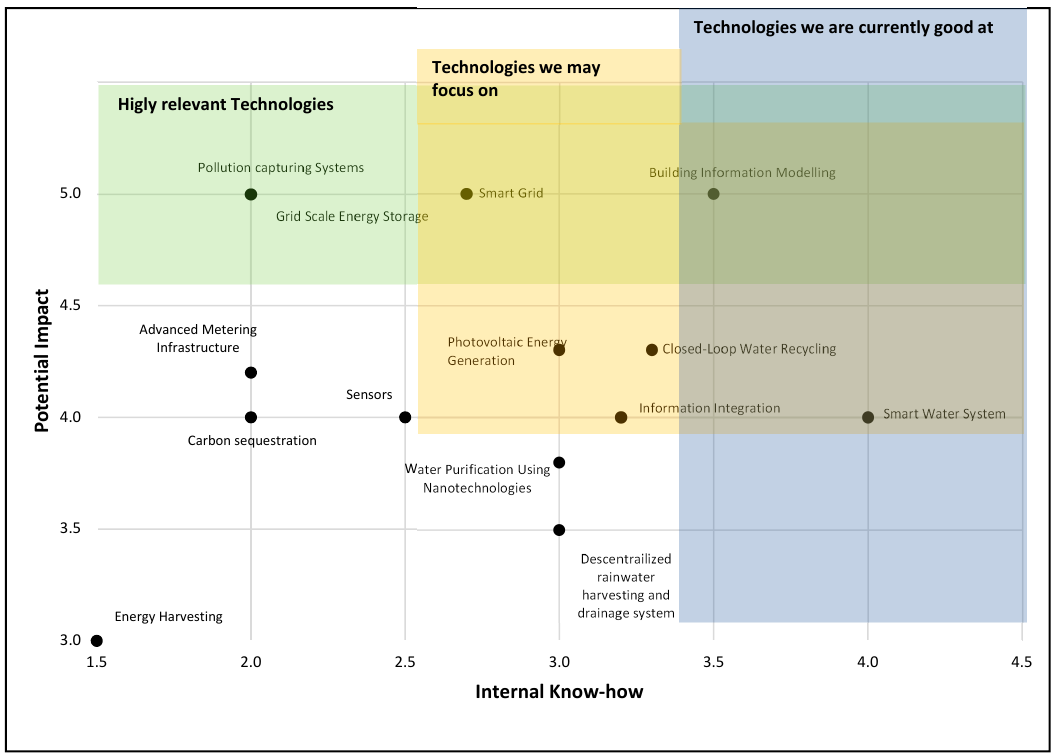
Sensors 2021 , 21 , x FOR PEER REVIEW Figure 3. Potential impact vs. internal know-how. Figure 2. Potential impact vs. internal know-how.